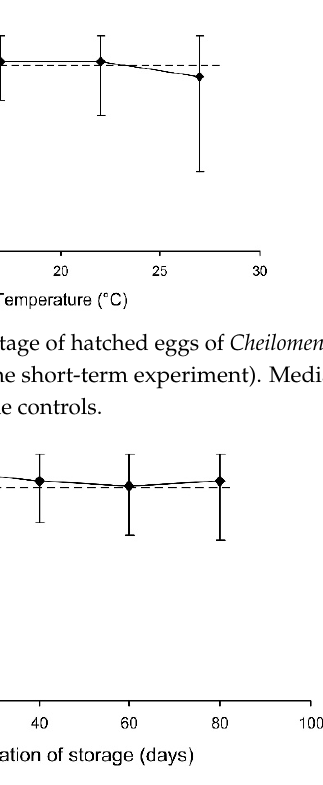
Figure 7. The percentage of hatched eggs of Cheilomenes propinqua females in relation to the duration of storage (the results of the long-term experiment). Medians and quartiles are shown. The dashed line shows hatching in the controls.